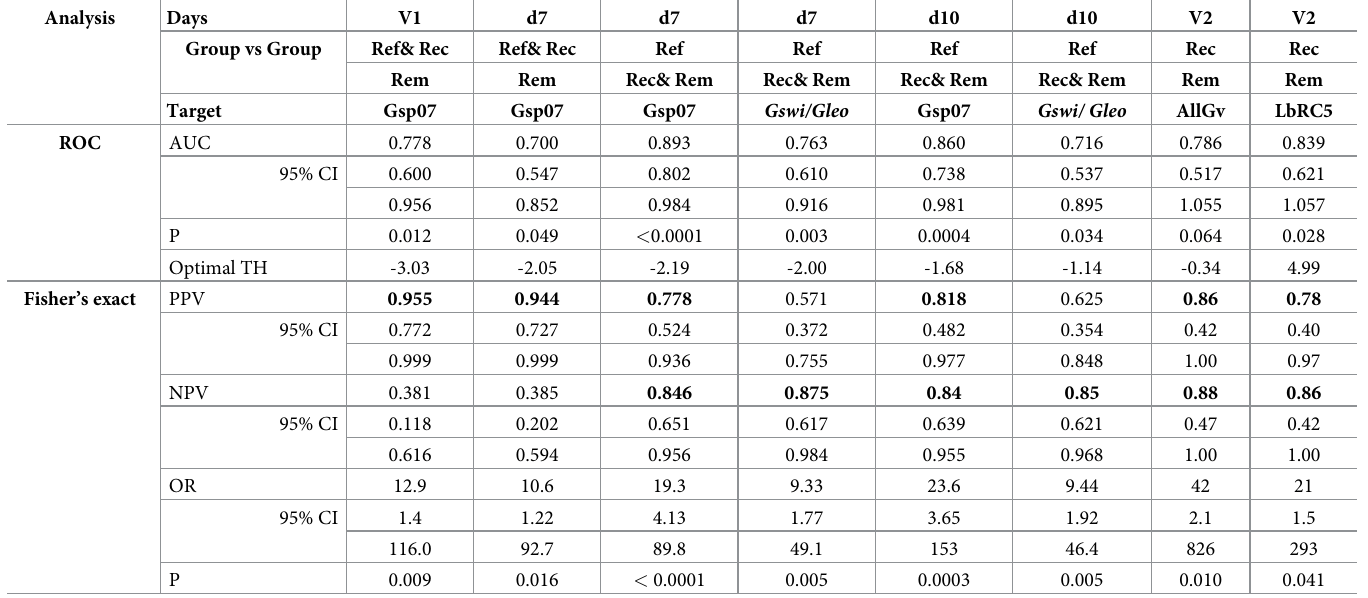
Table 3. Prognosis of clinical outcomes by relative abundance of Gsp07 or G . swidsinskii/G . leopoldii , and LbRC5 scores at intervals from initiation of metronida- zole therapy.